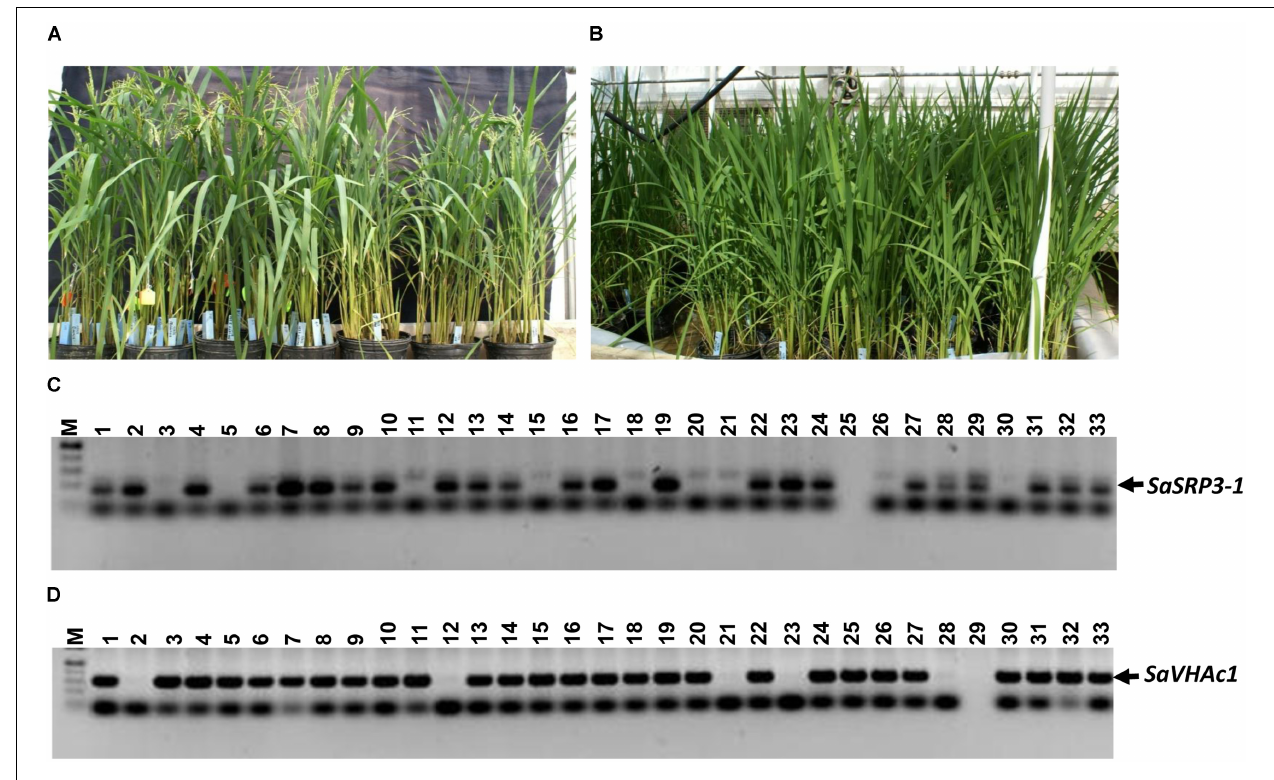
FIGURE 4 | Transgenic plants grown in green house and PCR analysis to confirm the integration of SaSRP3-1 and SaVHAc1 genes in pyramided progenies. (A) Pyramiding of SaSRP3-1 (T 1 ) and SaVHAc1 (T 2 ) genes by crossing homozygous plants during flowering stage; (B) Growth of pyramided progenies with both genes; (C) PCR amplification showing the presence of SaSRP3-1 gene; (D) Pyramided transgenic rice plants showing the amplification of SaVHAc1 gene using gene specific